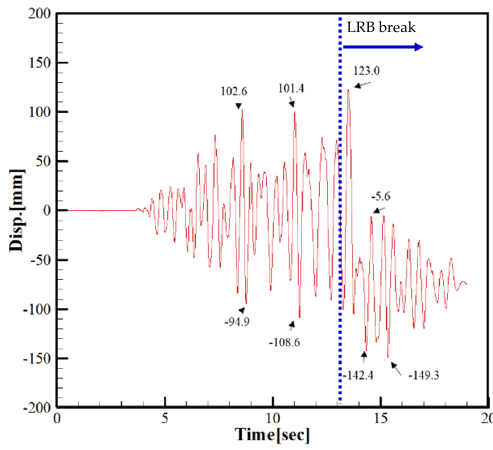
Figure 16. Displacement–time history of dummy mass before and after the LRB break.